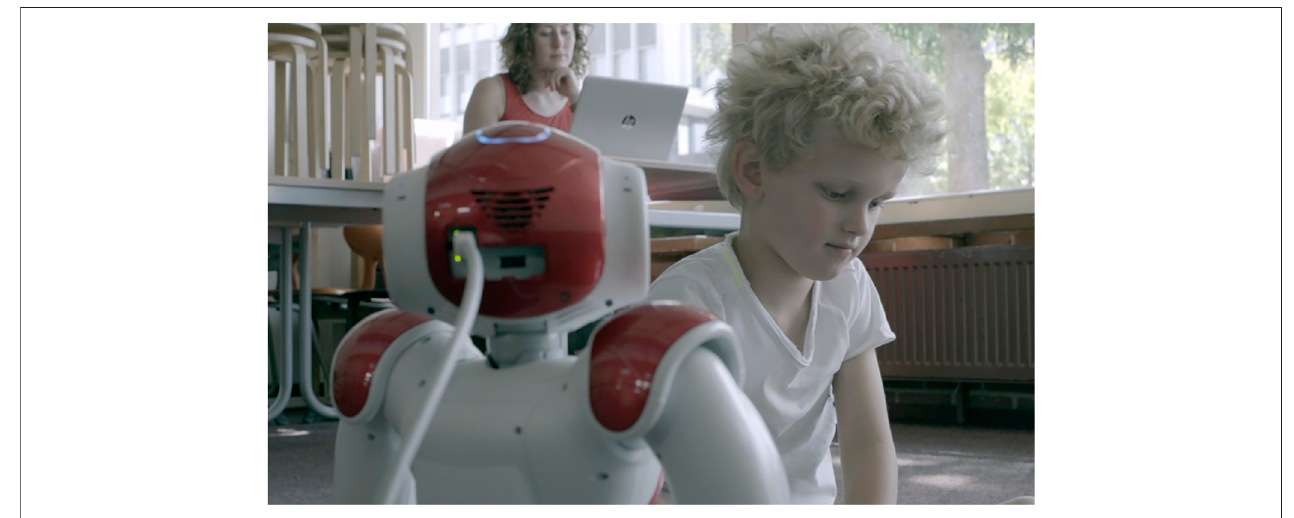
FIGURE 2 | A child engaging in a lesson with the